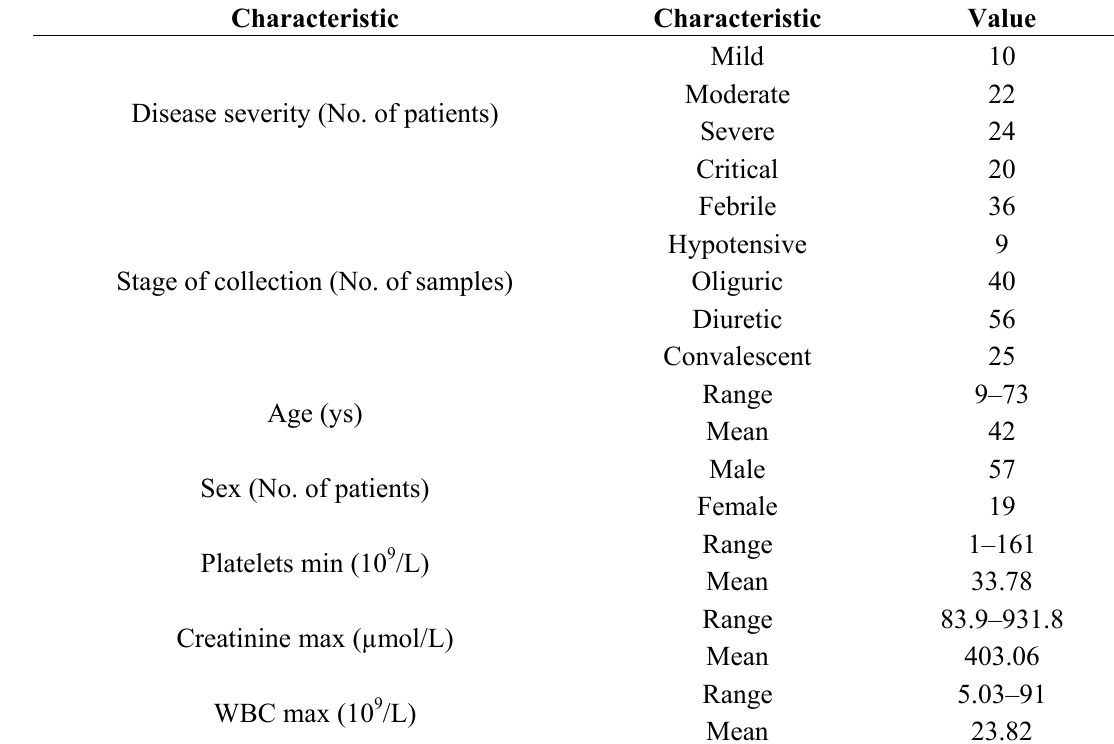
Table 1. Demographic and clinical characteristics of 166 plasma samples from 76 haemorrhagic fever with renal syndrome (HFRS) patients.